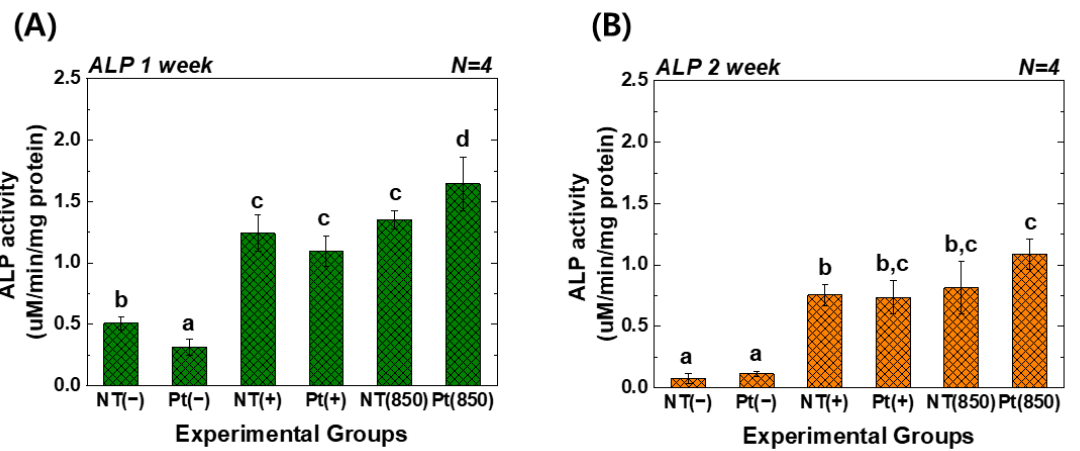
Figure 5. ALP activity values of TiO 2 NT and Pt-TiO 2 NT after ( A ) one week and ( B ) two weeks of incubation (In each graph, the experimental groups with different letters indicate statistical significance by one-way ANOVA at α = 0.05).